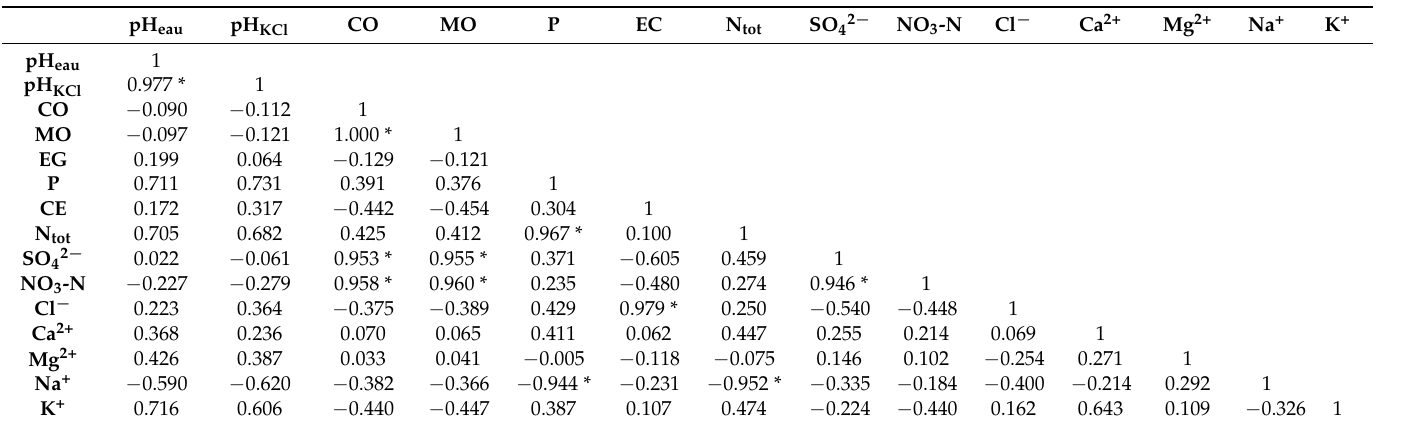
Table 3. Pearson’s correlation coefficients for physicochemical parameters of soil